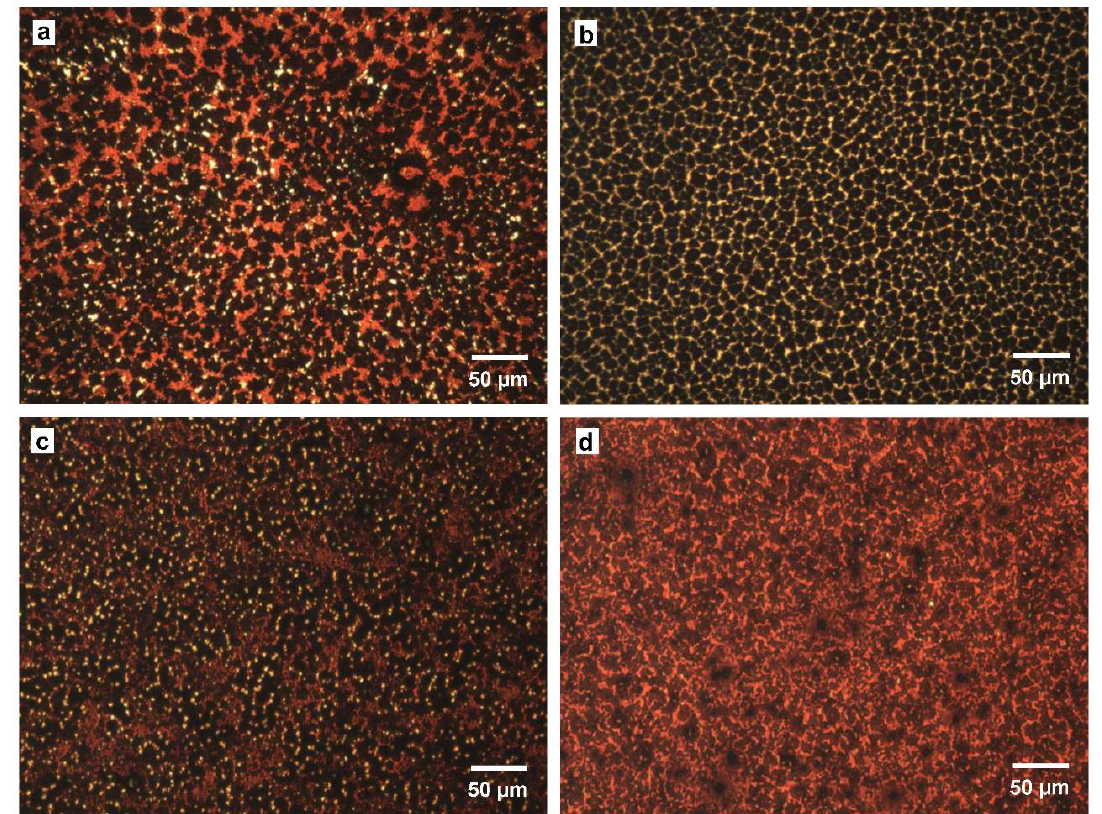
Figure 4. Optical microscope images of cells prepared with chlorobenzene and annealed at ( a ) 140 °C and ( b ) 190 °C; and cells prepared with DPPS in chlorobenzene annealed at ( c ) 190 °C and ( d ) 220 °C.